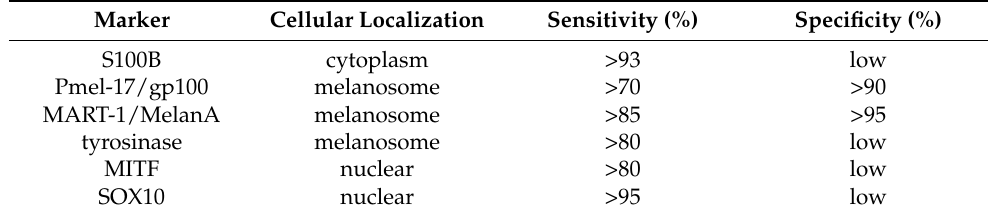
Table 2. Immunohistochemical markers of melanoma